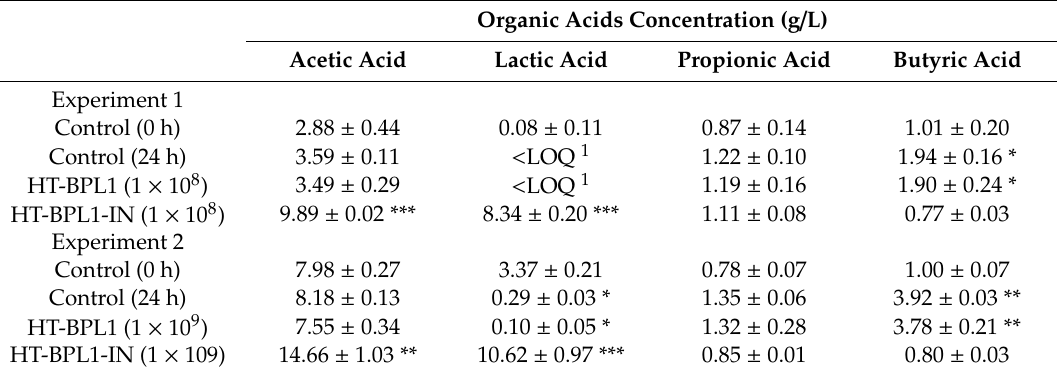
Table 1. Levels of short-chain organic fatty acids in slurry fermentations in the absence (control 24 h) or the presence of HT-BPL1 alone or with milk powder supplemented with HT-BPL1 (HT-BPL1-IN). Organic Acids Concentration (g/L) Acetic Acid Lactic Acid Propionic Acid Butyric Acid